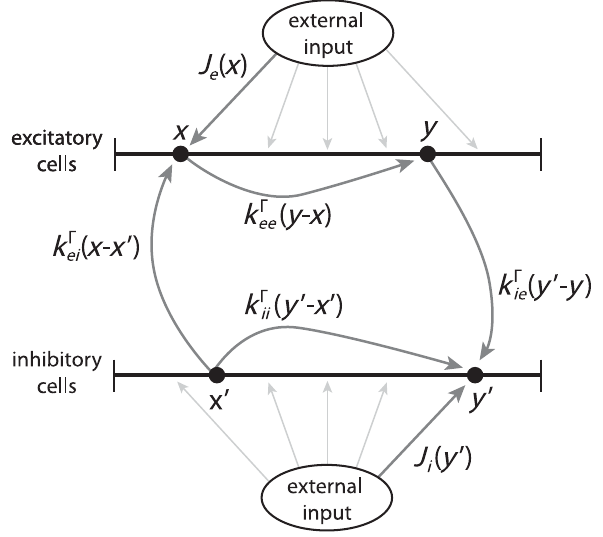
FIG. 1. Network diagram. Excitatory and inhibitory cells are arranged on the one-dimensional state space Γ ¼ ð 0 ; 1 (cid:1) with periodic boundary conditions. An excitatory cell at location x receives input from an inhibitory cell at location x 0 with probability k Γ , and k Γ , where ð x − x 0 Þ , and similarly for k Γ ee , k Γ ei ie ii k Γ αβ ð x Þ is the periodic summation of k αβ ð x Þ on Γ ; see Eq. (2). An excitatory cell at location x receives temporally constant external x Þ , and similarly for J x Þ input with intensity J e ð i ð